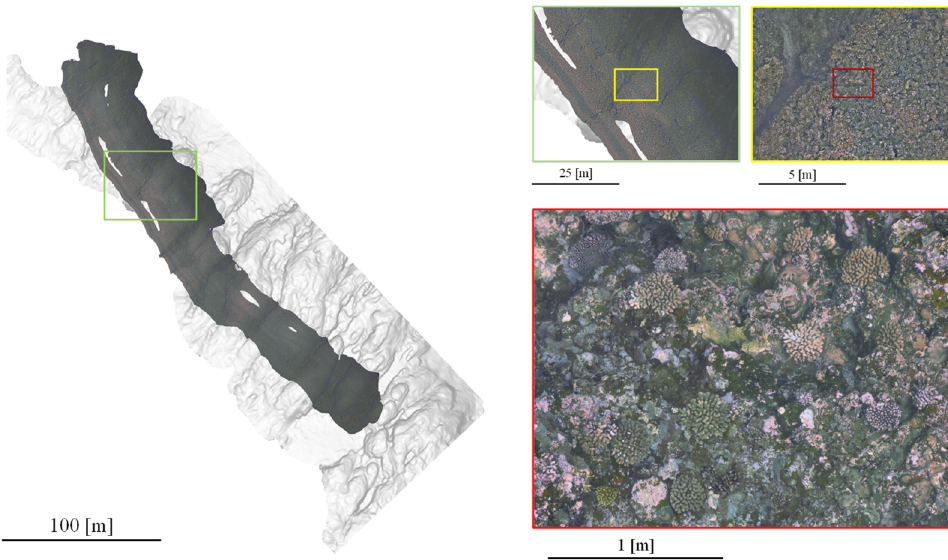
Figure 3. The 2-D image (orthophoto) at various scales. The 2-D image is overlaid on the hill-shaded topography generated from MBES data. The survey was conducted in the northern coastal area of Kumejima.